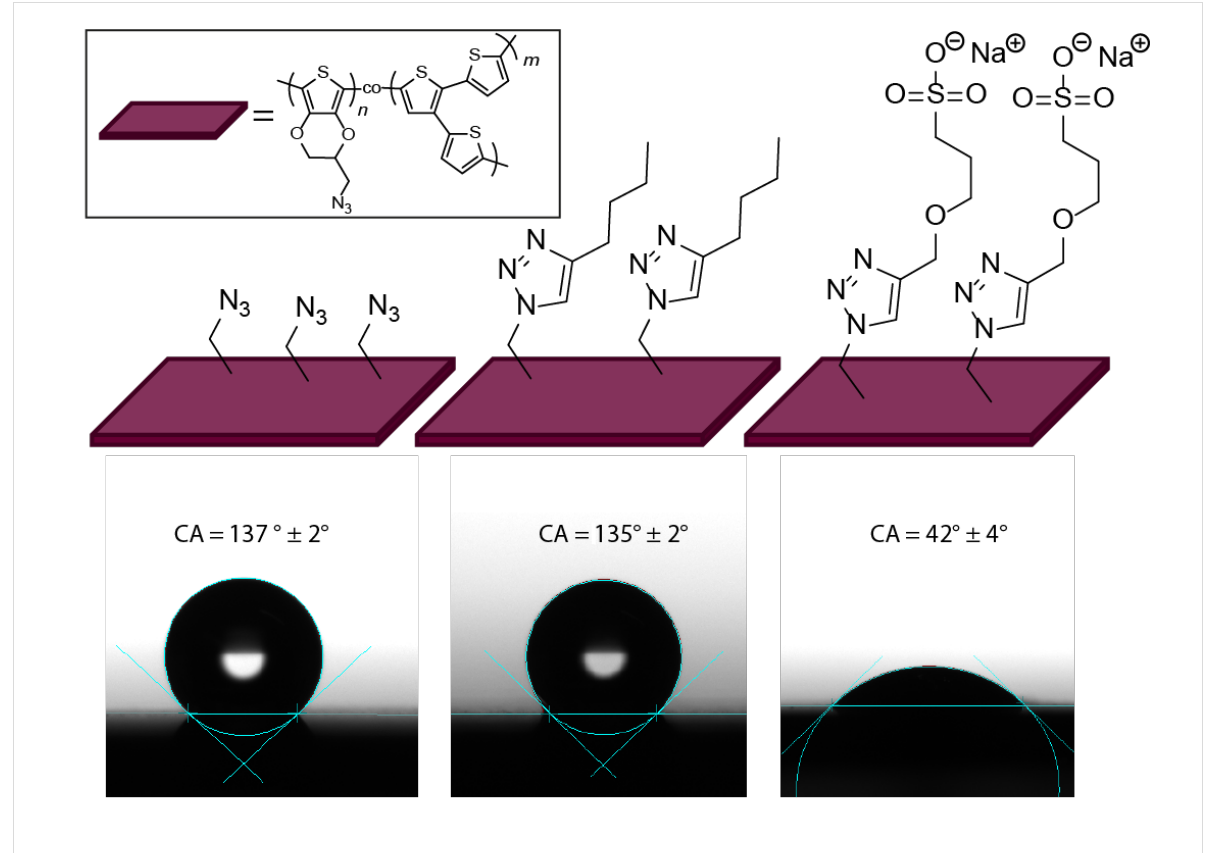
Figure 5: Water contact angle (CA) of the films of P(EDOT-N 3 -co- 3T) (left), P(EDOT-clickHex -co- 3T)-1:1 (middle) and P(EDOT-clickSO 3 Na -co- 3T)- 1:1 (right).